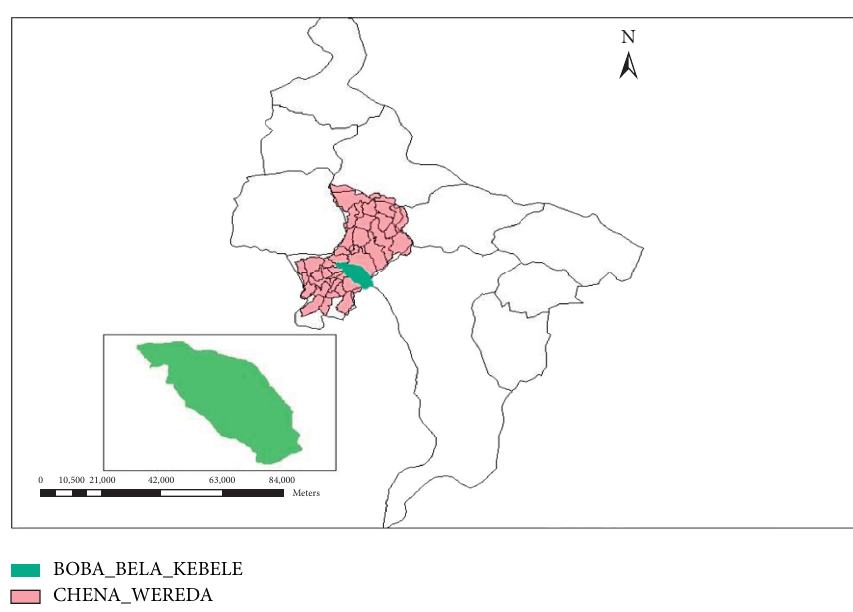
Figure 1: Map of the study